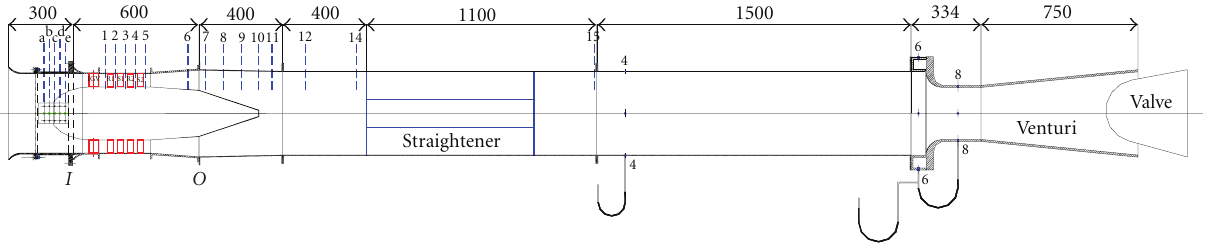
Figure 3: Two-stage compressor test facility.